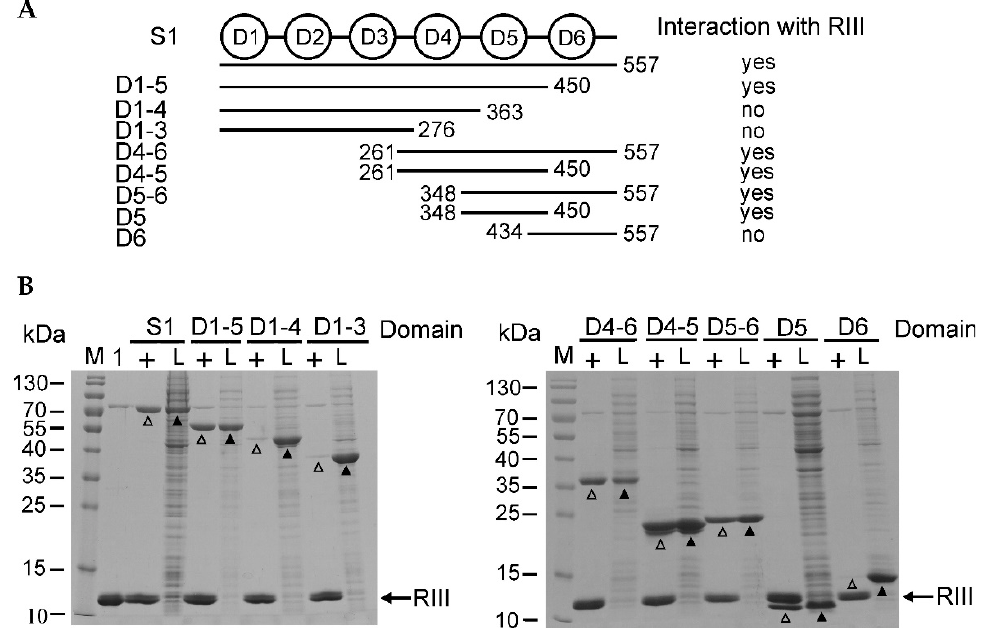
Figure 2. The pull-down assay of in vitro interaction between the recombinant His-tagged RIII protein and untagged S1 as well as its truncated variants. ( A ) The schematic representation of the domains of the intact ribosomal protein S1 (six domains) and its truncated variants used for analysis. The numbers next to the lines mean the amino acid positions of S1. ( B ) The images of the pull-down assay of the induced recombinant proteins followed by SDS-PAGE (14%). The recombinant His-tagged RIII was bound to the His-affinity agarose, which was washed and then mixed with the cell lysates containing either induced intact S1 or its truncated variants (indicated on the top of the image). Lanes: M—PageRuler™ Prestained Protein Ladder (Thermo Fisher Scientific, Vilnius, Lithuania), 1—the sample of the purified His-tagged RIII protein, +—immobilized RIII used as a bait protein, L—the samples of cell lysates having induced prey proteins. The positions of S1 and its truncated variants in lysates are marked with black arrowheads and open arrowheads indicate S1 variants eluted together with the His-tagged RIII. The black arrows show the position of the His-tagged RIII protein.